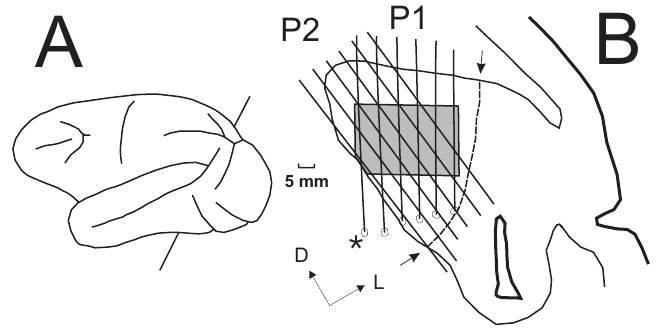
Fig. 2 – Oblique frontal sections (B), at the level indicated in the lateral reconstruction of the hemisphere (A). Arrows indicate the borders of MT. Electrode tracks are indicated by vertical and oblique lines. The boundaries of area MT were determined based on myeloarchitecture. The asterisc indicate the array of penetration with electrolitic lesions at the end of the electrode